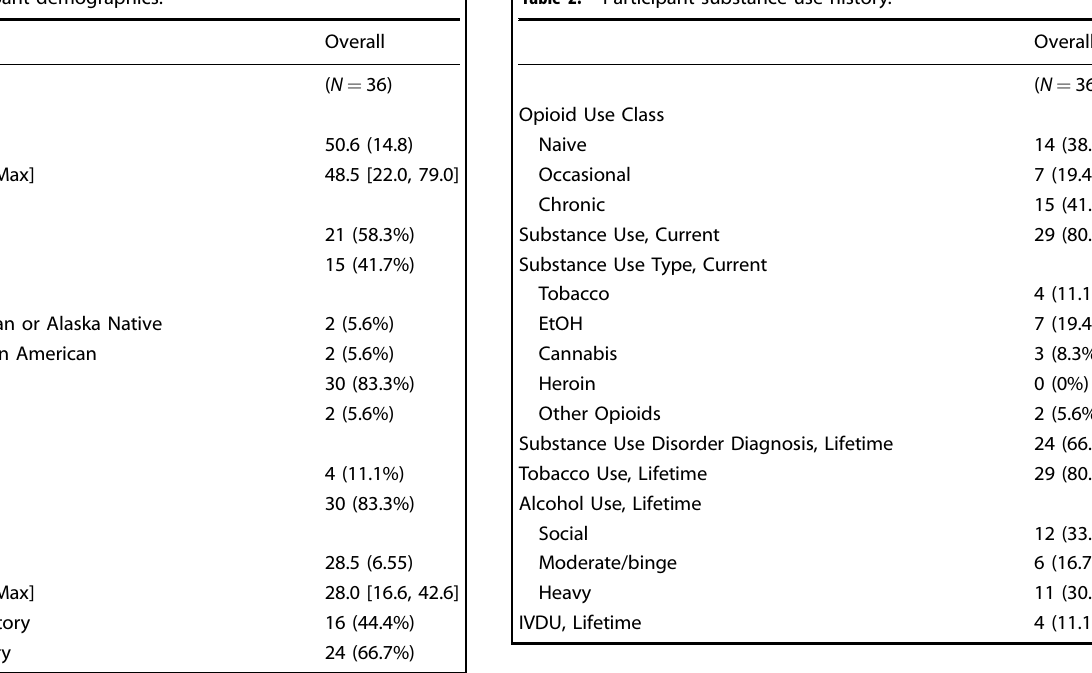
Table 1. Participant demographics. Table 2. Participant substance use